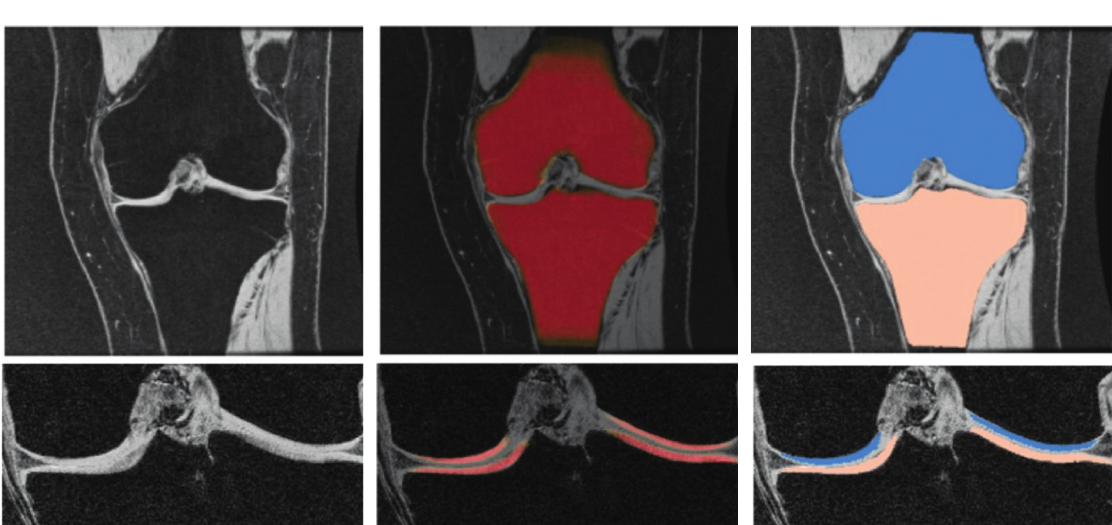
Figure 7: First row: segmentation of knee bone (left: original image, middle: automated segmentation, and right: segmented bone). Second row (left: original image, middle: automated segmentation, and right: cartilage segmented) (reproduced from reference [25]).